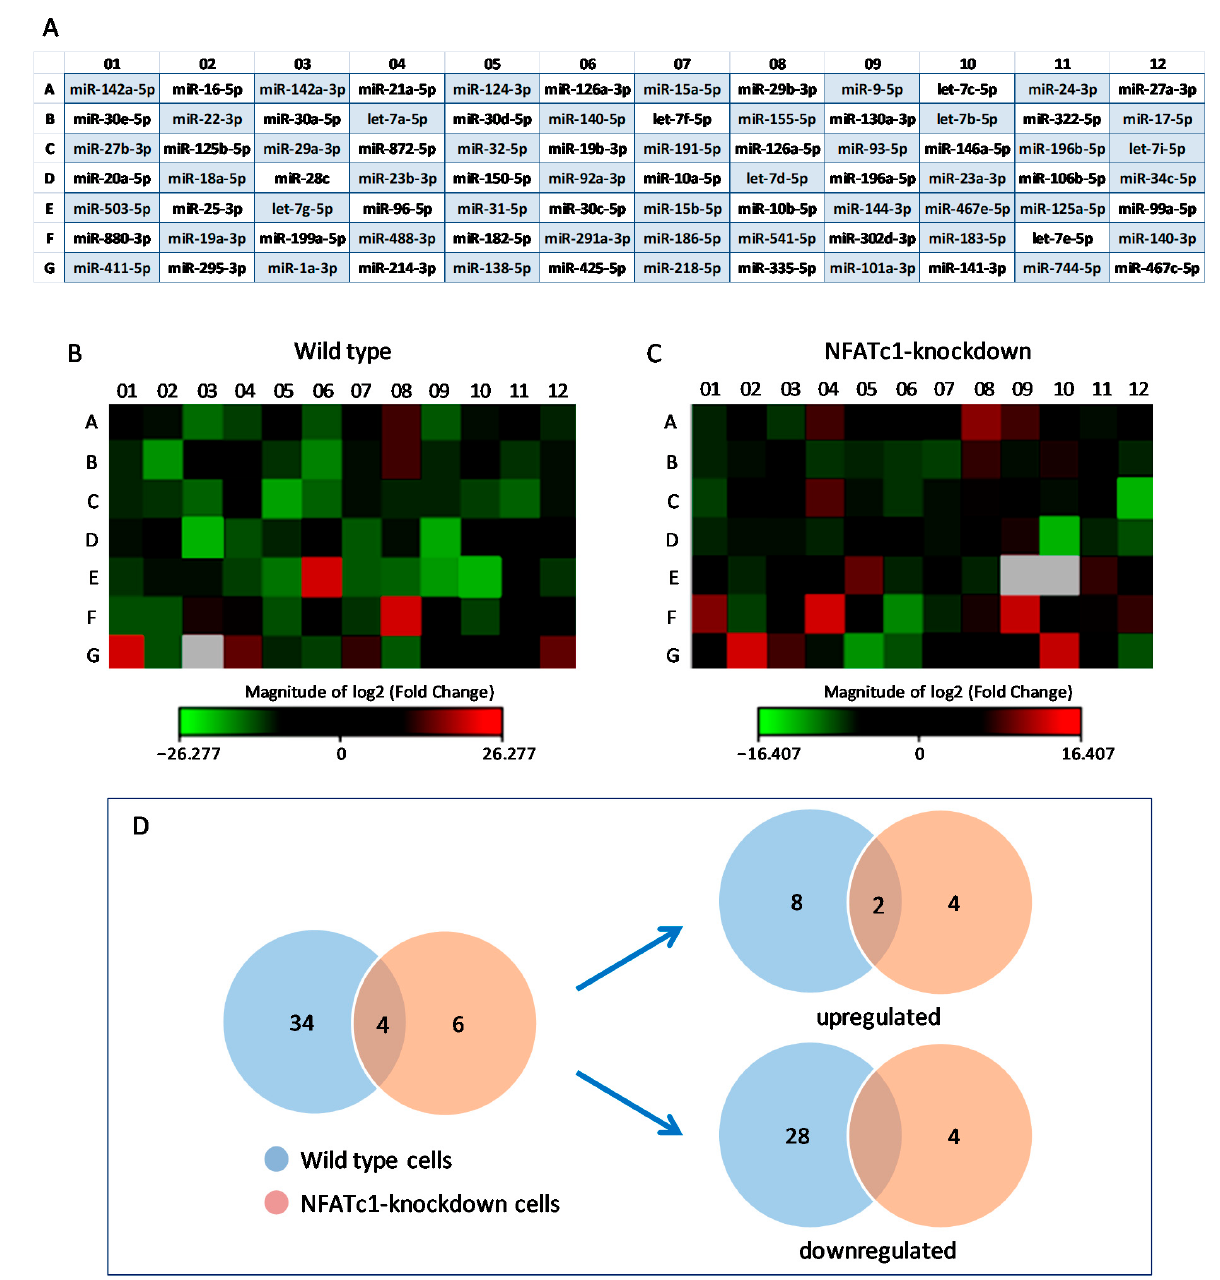
Figure 1. Differential expression profiling of miRNAs in RAW264.7 cells. ( A ) Heat-map legend showing the mouse miRNAs Profiler PCR array with all miRNAs analyzed. ( B ) Heat-map profile showing the resulting PCR array dataset derived from the normalization of RANKL + versus RANKL − cells (wild-type). ( C ) Heat-map profile showing the resulting PCR array dataset derived from the normalization of RANKL + cells transfected with NFATc1 siRNA (NFATc1-knockdown) versus those transfected with negative control (NC) siRNA. Red squares, upregulated miRNAs; green squares, downregulated miRNAs; black squares, unchanged miRNAs; grey squares, technically unacceptable data. These latter were not considered in the analysis of our results. ( D ) PCR array data from the two treatments (wild-type and NFATc1-knockdown) were represented by Venn diagram. Table 1. Differentially expressed miRNAs in RANKL-stimulated RAW264.7 cells (fold change ≥ 2).